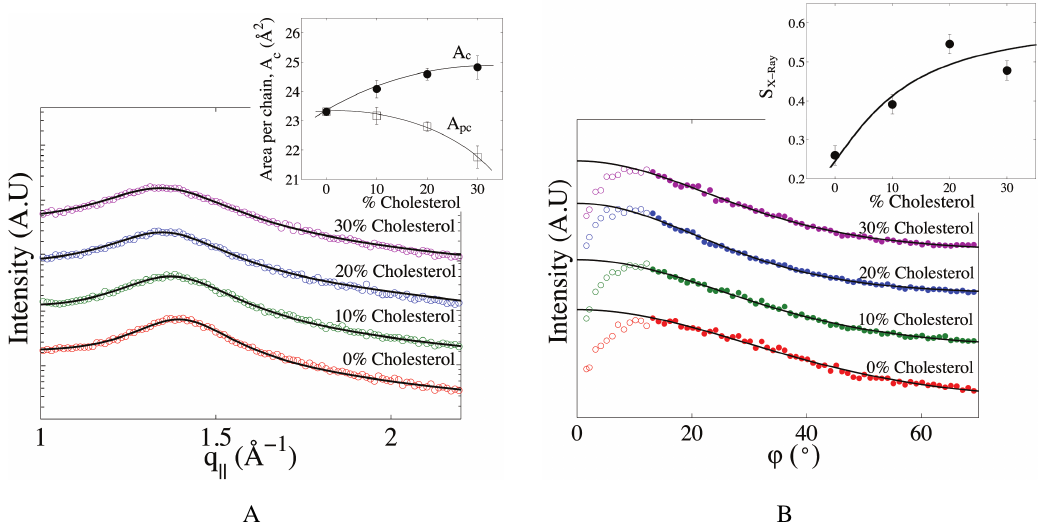
Effect of cholesterol on the packing and orientational order of mitochondria-like membranes. ( A ) Chain correlation peaks for mitochondria-like membranes containing between 0 and 30 mol% cholesterol. Each curve is fit with a Gaussian profile on a slopping background (solid lines). Curves are shifted vertically for clarity. Inset: average area per chain ( i.e ., including cholesterol chains), A c , directly inferred from the position of the peak (filled symbols), compared to the average area per phospholipid chain, A pc , as corrected for cholesterol volume using Equation (2) (open symbols). Solid lines are a guide for the eyes. ( B ) Integrated intensities of the chain correlation peak as a function of polar angle. Curves are shifted vertically for clarity. Continuous lines represent fits of the filled symbol data with Equation (4), while the open symbols were not included in the fit. Inset: X-ray chain orientational order parameter, S X-ray , calculated from that